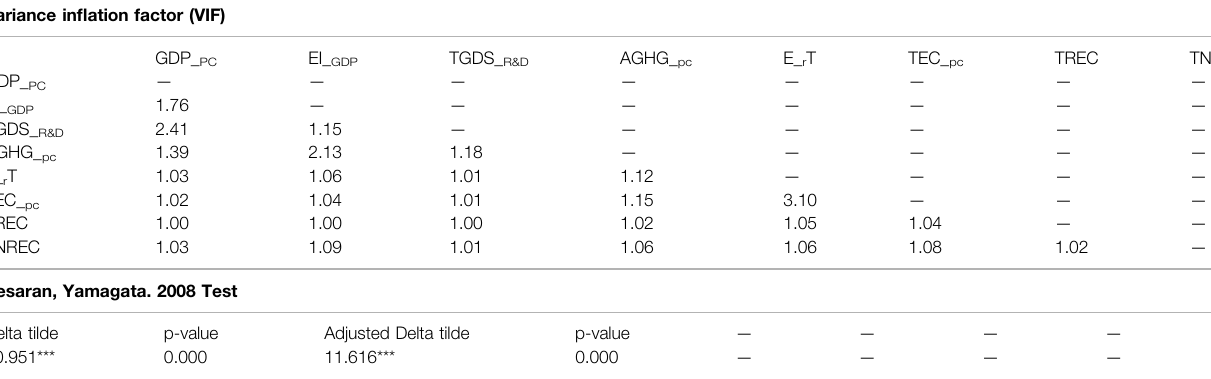
TABLE 3 | Results of the multicollinearity test and homogeneity test. Variance in fl ation factor (VIF)